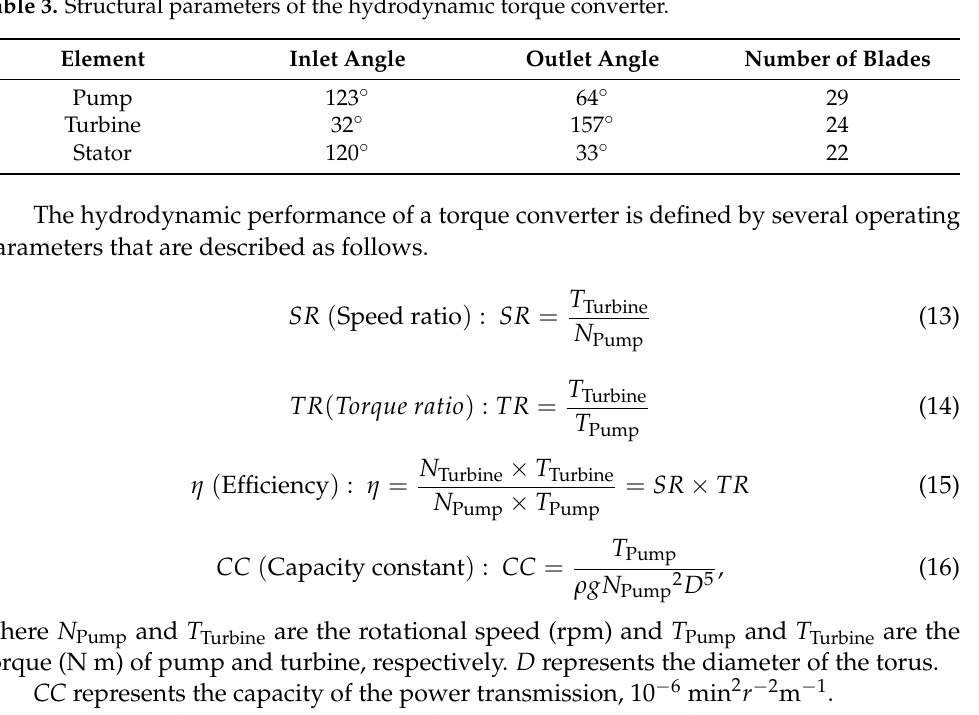
Table 3. Structural parameters of the hydrodynamic torque